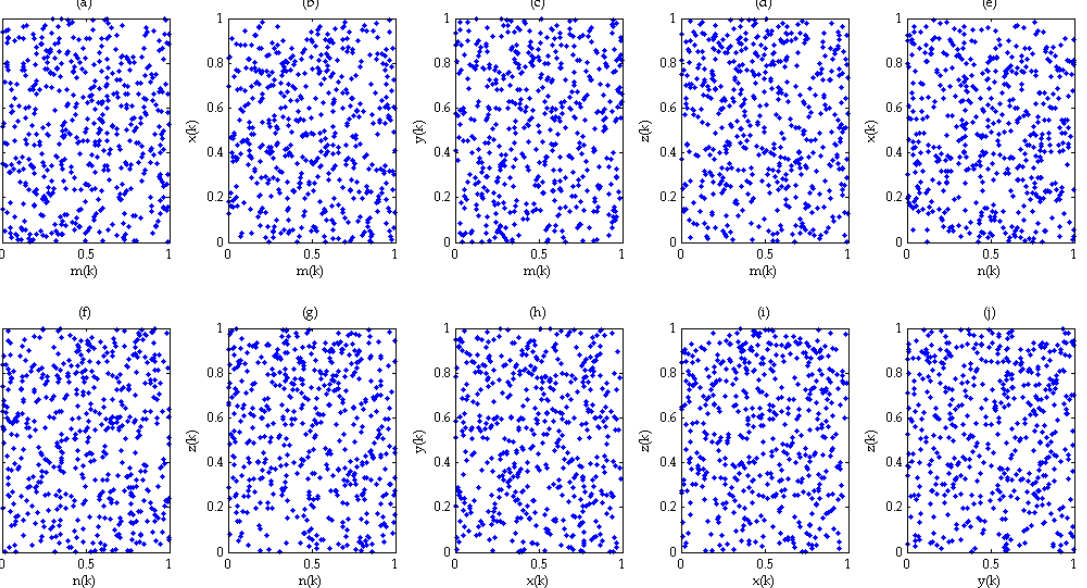
Figure 5. Phase diagram of the five-dimensional system (2): ( a ) M–N phase diagram; ( b ) M–X phase diagram; ( c ) M–Y phase diagram; ( d ) M–Z phase diagram; ( e ) N–X phase diagram; ( f ) N–Y phase diagram; ( g ) N–Z phase diagram; ( h ) X–Y phase diagram; ( i ) X-Z phase diagram; ( j ) Y–Z phase diagram; ( k ) M–N–X phase diagram; ( l ) M–N–Y phase diagram; ( m ) M–N–Z phase diagram; (n) M–X–Y phase diagram; (o) M–X–Z phase diagram; ( p ) M–Y–Z phase diagram; ( q ) N–X–Y phase diagram; ( r ) N–X–Z phase diagram; ( s ) N–Y–Z phase diagram; ( t ) X–Y–Z phase diagram.